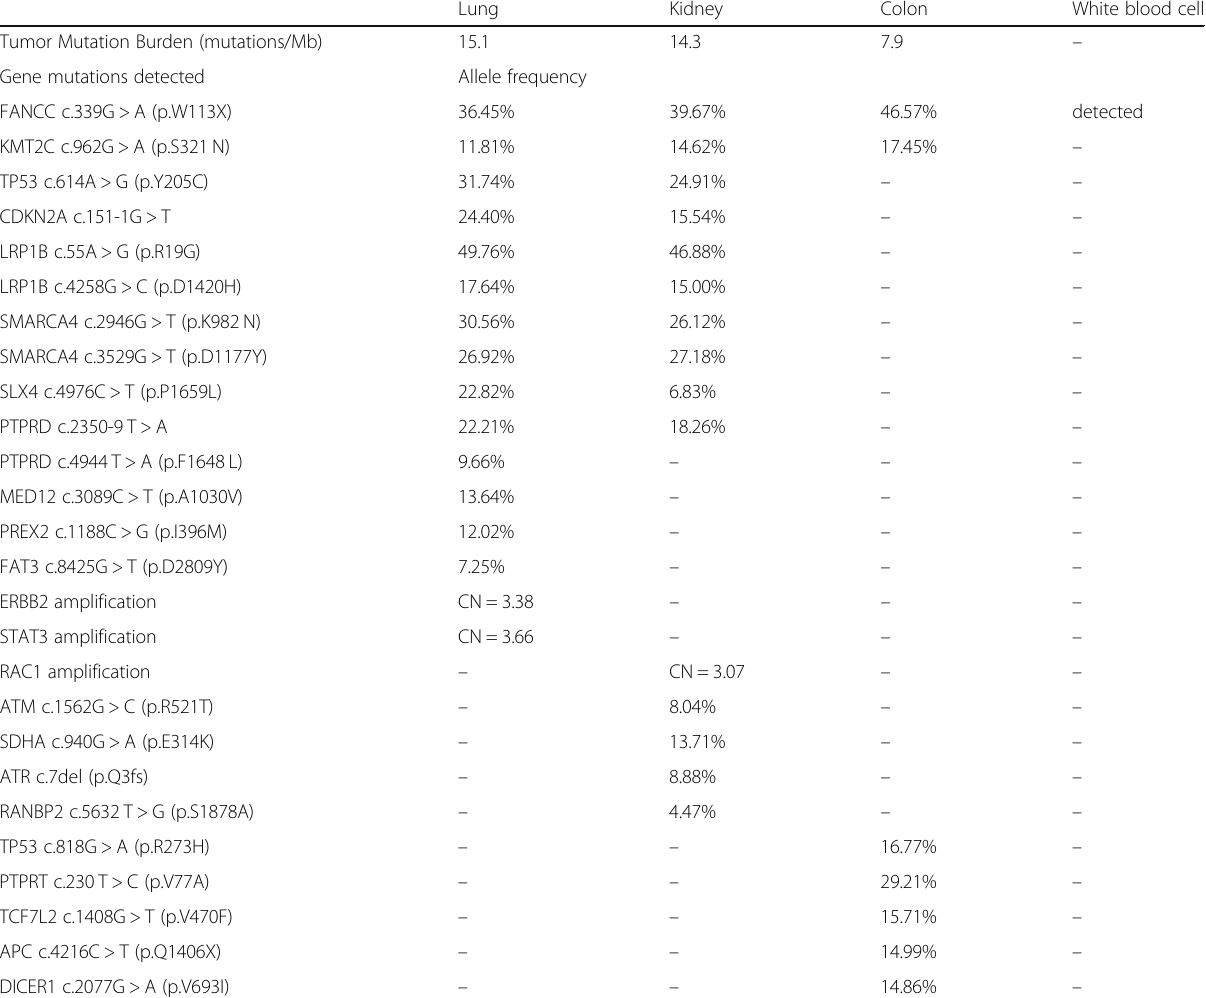
Table 2 Gene mutations detected in the lung, kidney and colon tumor samples